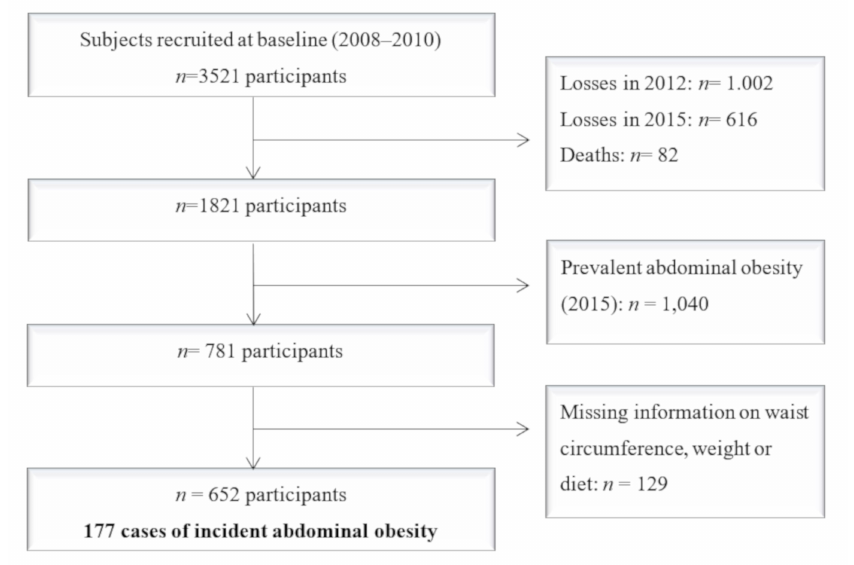
Figure 1. Flow chart of